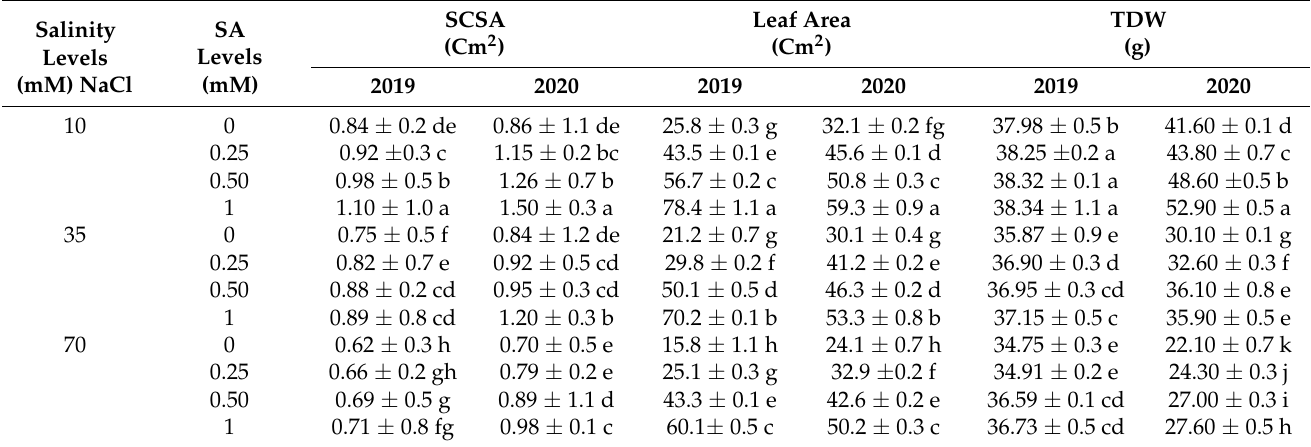
Table 2. Means of stem cross-sectional area (SCSA), leaf area, and total dry weight (TDW)